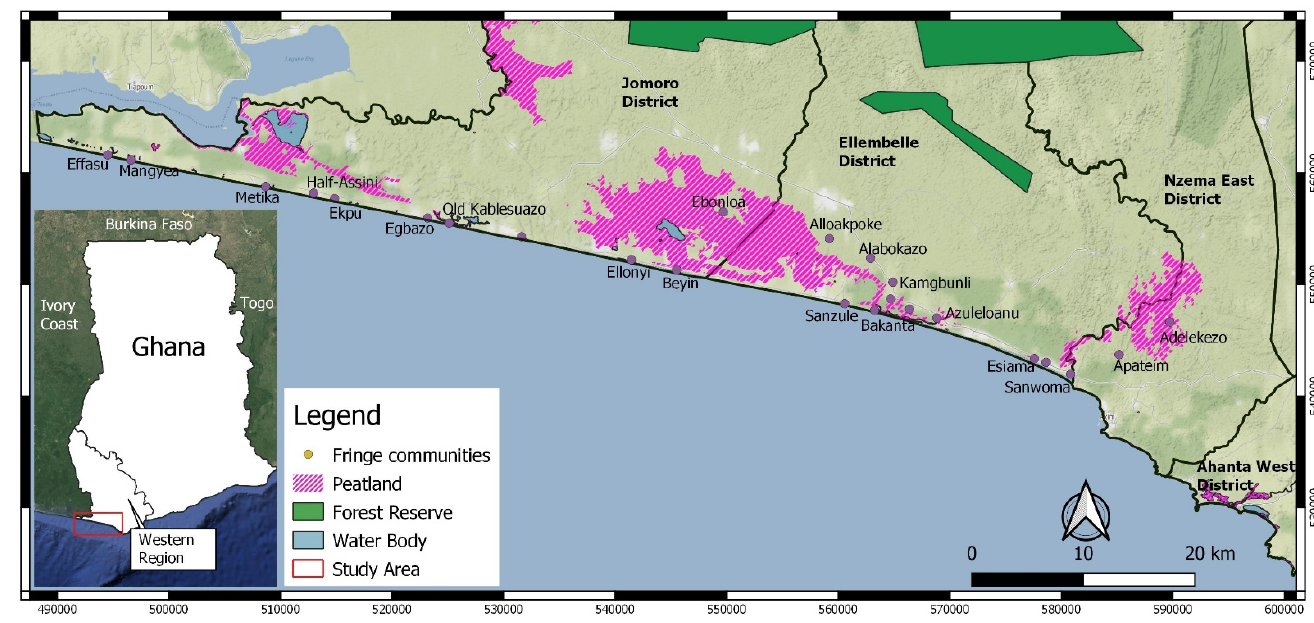
Figure 1. The Greater Amanzule landscape showing identified patchy peatlands and communities fringing the wetland resources. Peatland information was obtained from Hen Mpoano’s data repository and is based on participatory GIS and ground truthing approach.